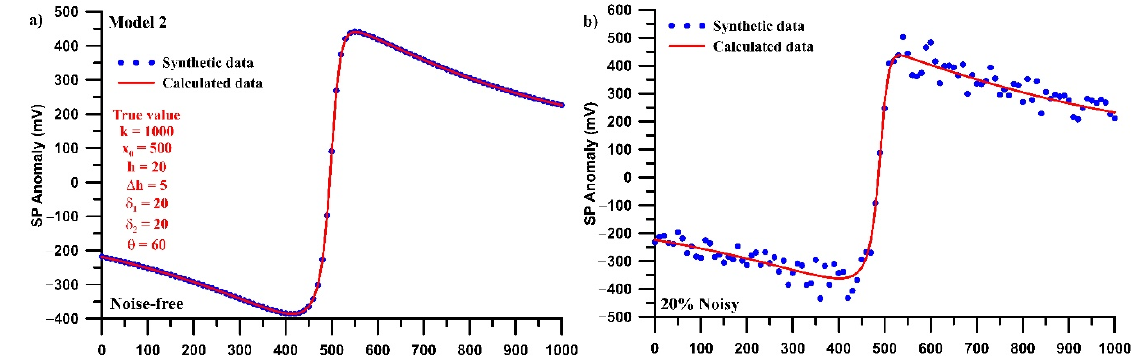
Figure 7. Fits for Model 2: ( a ) Noise-free and ( b ) Noisy synthetic data.